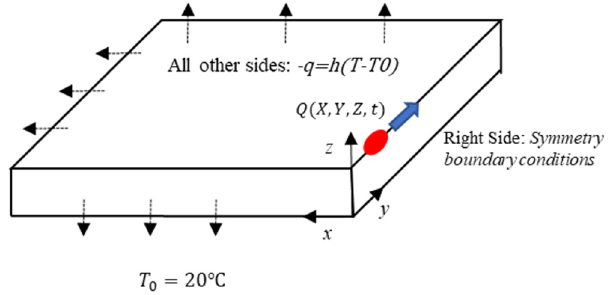
Fig. 3. The thermal boundary in the FEA model.